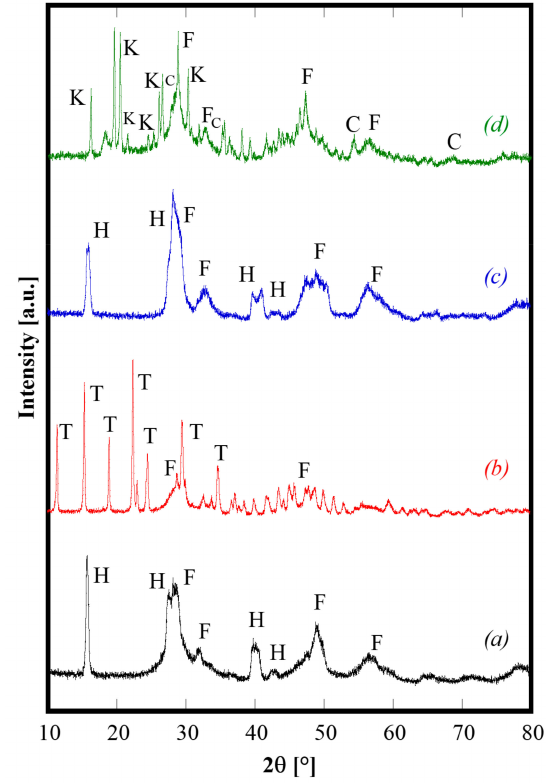
Figure 1. Di ff raction patterns of CeZrYLaGd-N (pattern a ), CeZrYLaGd-U (pattern b ), CeZrYbLaGd-N (pattern c ) and CeZrYbLaGd-U (pattern d ) samples hydrothermally synthesized at 120 ◦ C for 60 h. H, F, T, K and C label Hydroxides, Fluorite, Tengerite, Kozoite and Oxy-carbonate phases,